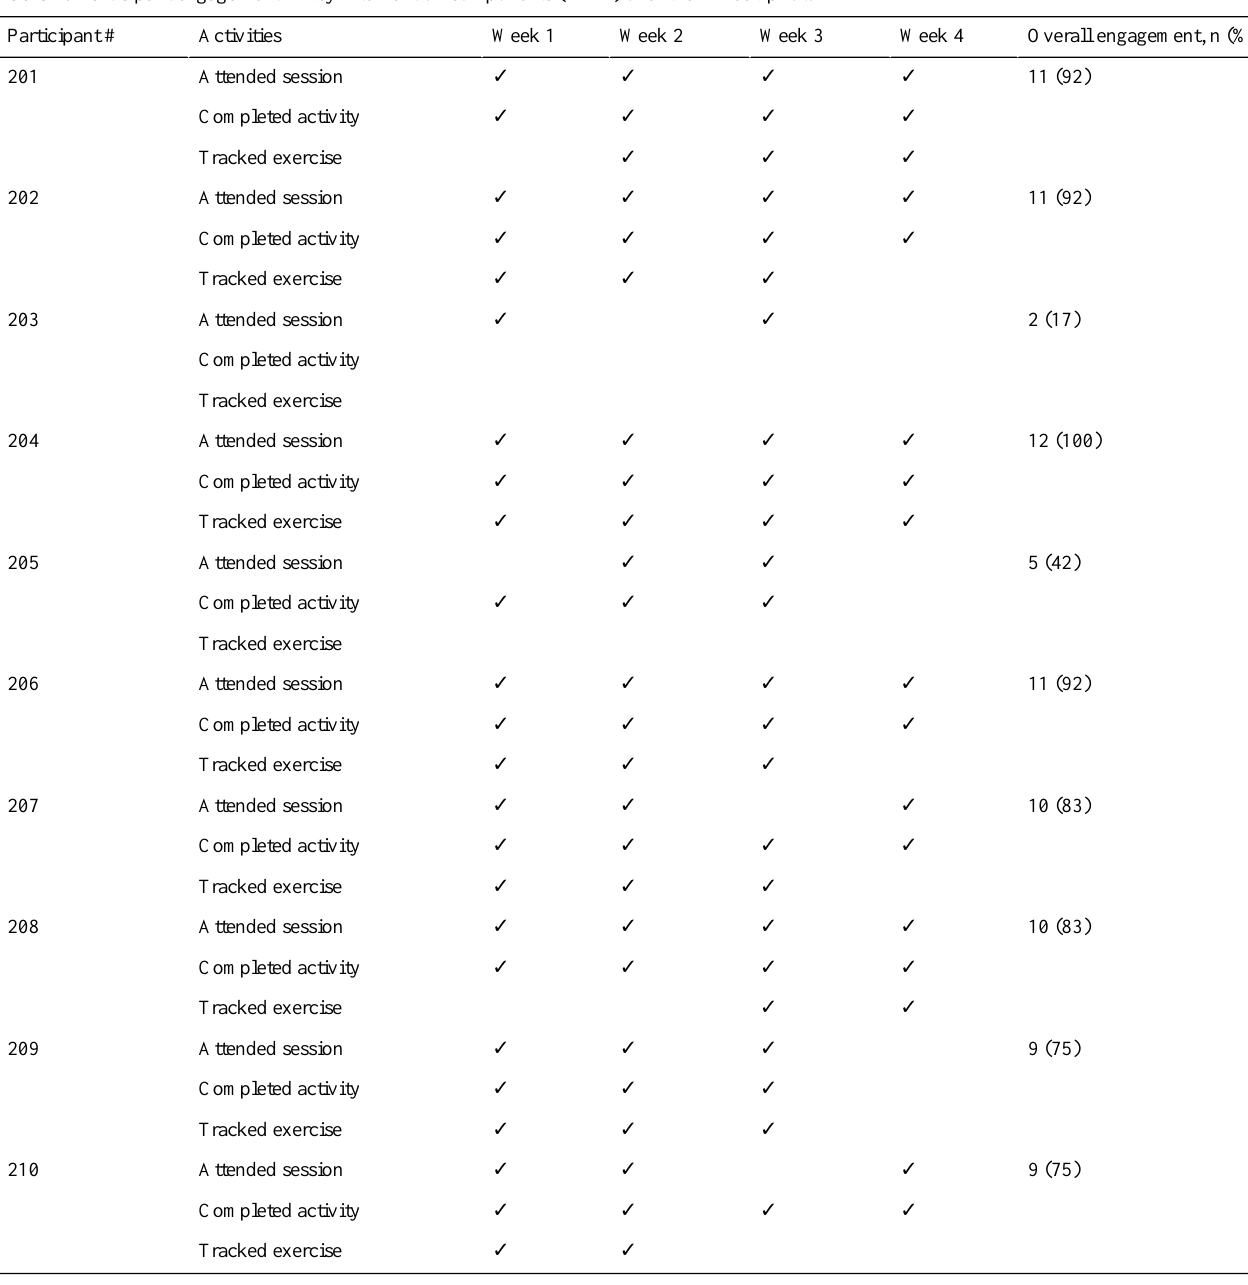
Table 2. Participant engagement in key intervention components (N=12) over the 4-week pilot.